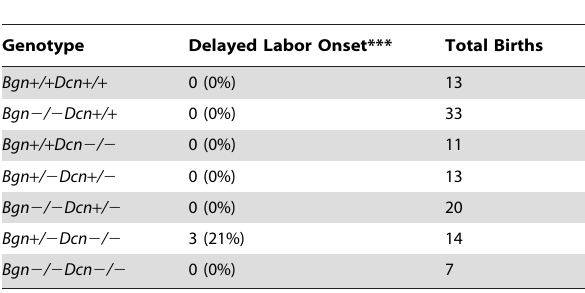
Table 1. Bgn + / 2 Dcn 2 / 2 dams display an increase in length of gestation (delayed onset of parturition after embryonic day 21) compared to all other genotypes.